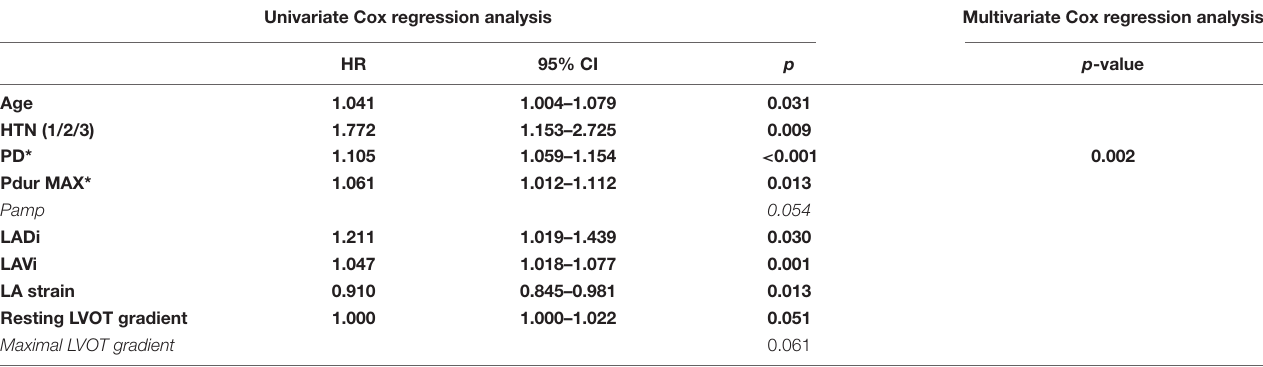
TABLE 5 | Independent predictors for incident AF in HCM patients with LAD < 45 mm.